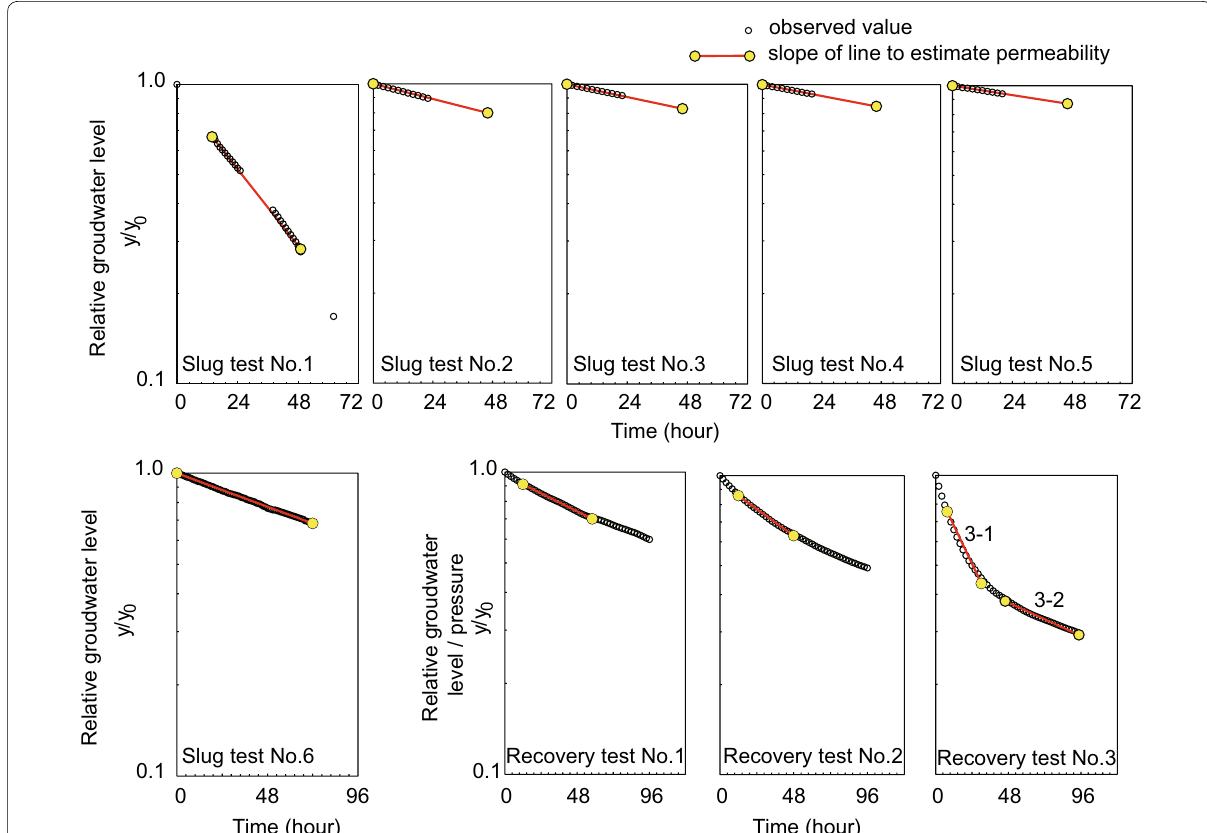
Fig. 3 Results of six slug tests and three recovery tests performed to determine permeability at Hole 1